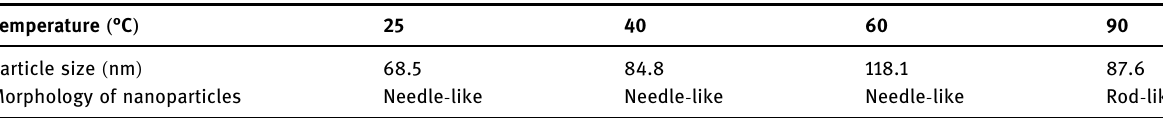
Table 1: In fl uence of temperature on the synthesis of nano - HA [ 15 ]